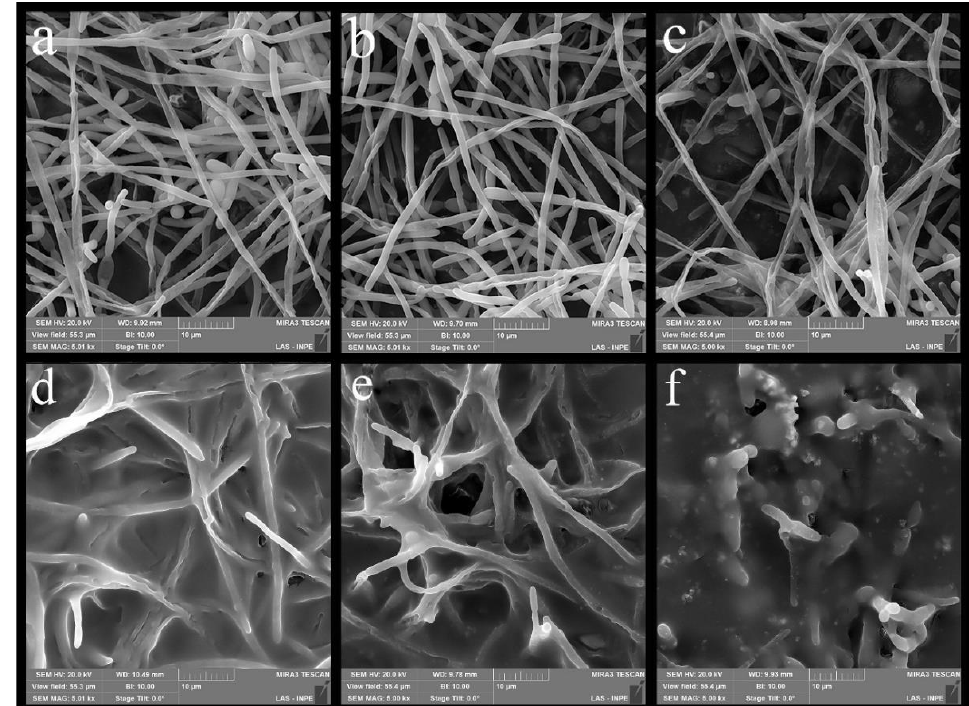
Figure 8. Images obtained by MEV-FEG of the biofilm formed on the surface of the nanocomposites: ( a ) CG group, ( b ) G1 group, ( c ) G2 group; ( d ) CR group, ( e ) R1 group, ( f ) R2 group.